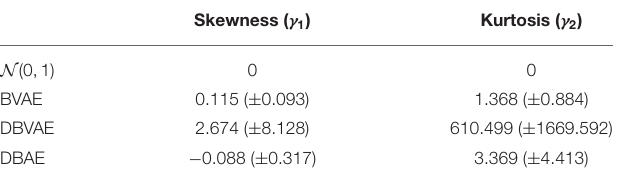
TABLE 2 | The ratio δ between the models with best β settings and the worst β setting in all experiments. a b d e f ae ef ALL Michigan BVAE A smaller number indicates less effects of β on system performance.